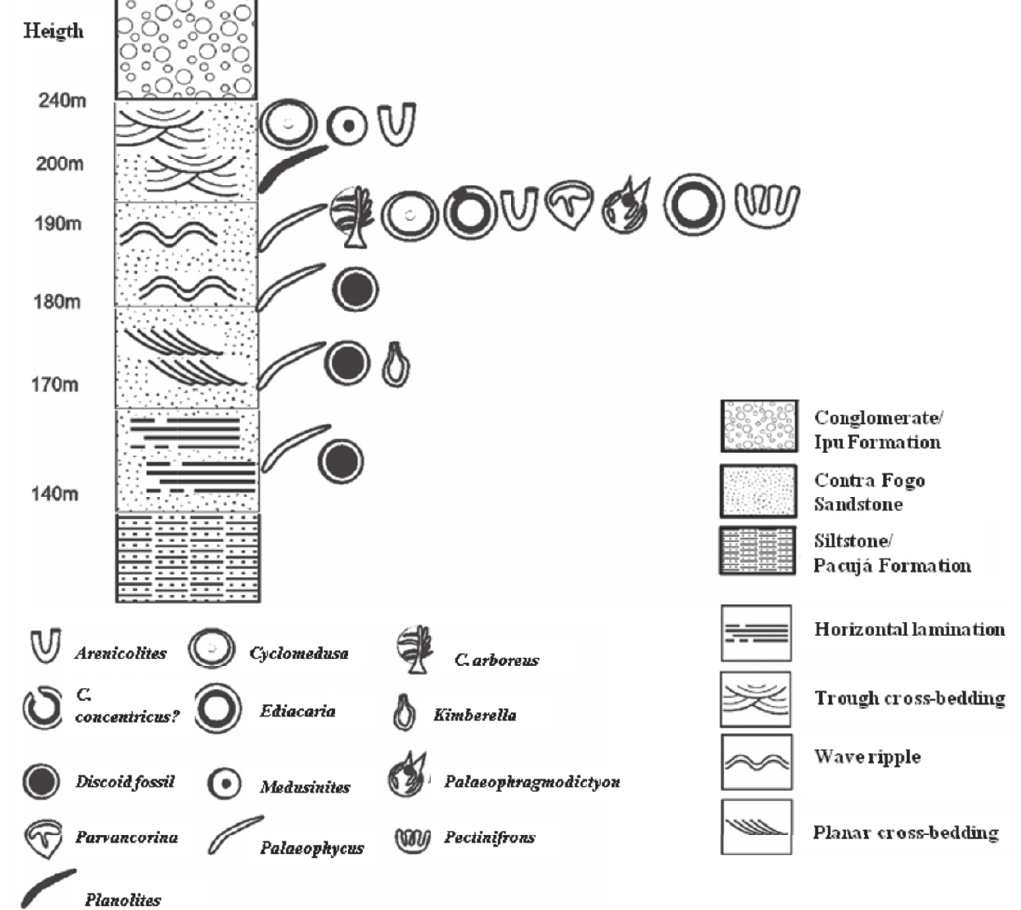
Figure 3 - Stratigraphic distribution of fossils in the profi